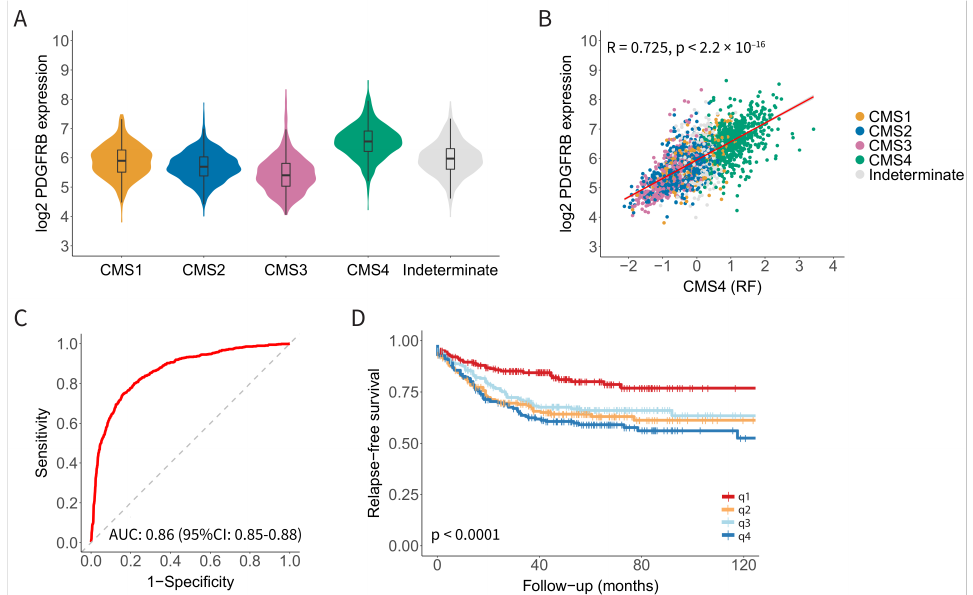
Figure 1. Platelet-Derived Growth Factor Receptor beta (PDGFRB) mRNA expression identifies Consensus Molecular Subtype 4 (CMS4) colorectal cancer (CRC) with high specificity and sensitivity. ( A ) Violin plot showing PDGFRB expression in the CMS subgroups in a composite RNA sequencing cohort of 3232 primary CRC tumours. ( B ) Scatter plot showing a strong correlation between PDGFRB expression and the CMS4-identifying gene set ( n = 143 genes; CMS4 (RF)) from the CMS classifier in the composite CMS-3232 cohort. ( C ) Receiver operating characteristic (ROC) curves showing the sensitivity and specificity of using PDGFRB mRNA levels to distinguish between CMS4 and CMS1-3. The Area Under the Curve (AUC) value is shown, as a measure of the diagnostic accuracy of the PDGFRB test. ( D ) Kaplan–Meier curves displaying relapse-free survival probabilities in subgroups defined by PDGFRB expression quartiles, n = 805 patients. There is a significantly worse relapse-free survival probability in the higher PDGFRB expression